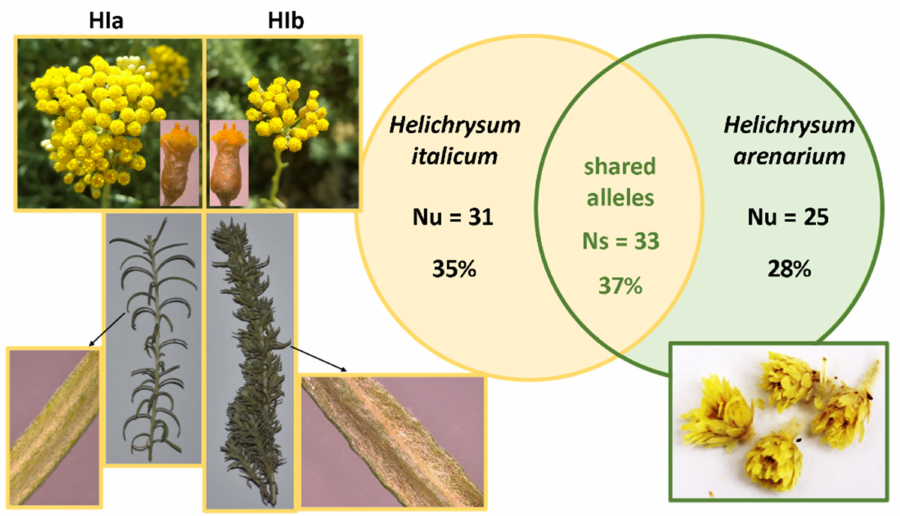
Figure 1. Plant material characterization. Taxonomically relevant differences among two identified HI morphological types HIa and HIb, the number (Nu) and the proportion of taxon-specific (unique) alleles for HI (Nu = 31; 35%) and HA (Nu = 25; 28%), and the number (Ns) and proportion of shared alleles among HI and HA (Ns = 33; 37%).